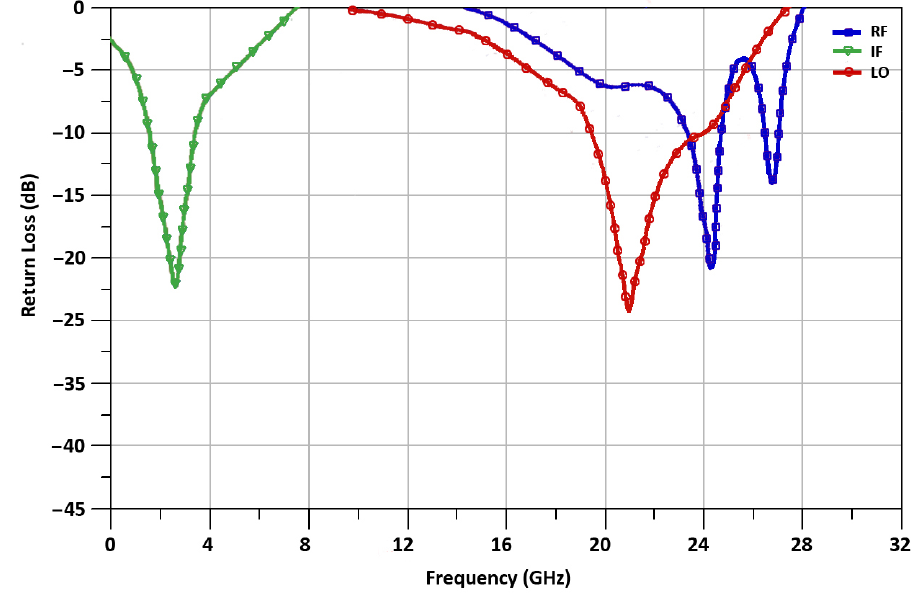
Figure 16. Measured return